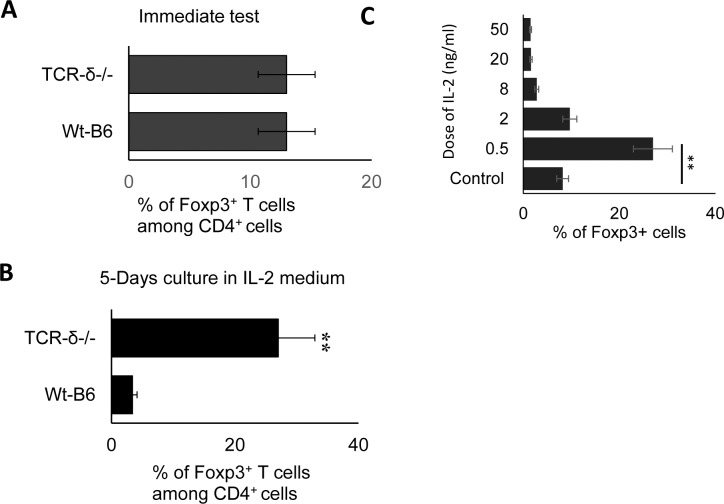
When cultured in medium containing low concentrations (1 ng/ml) of IL-2, a significantly large proportion of TCR-δ-/- T cells, as compared to wt-B6 T cells, expressed Foxp3.A&B). Groups (n = 6) of B6 and TCR-δ-/- mice were immunized with IRBP1-20/CFA. Thirteen days after immunization, CD3+ cells were separated from spleen and draining lymph nodes cells using a MACS column. They were stained with anti-mouse CD4 and anti-Foxp3 antibodies, either immediately (A) or after a 5-day culture in medium containing 1ng/ml IL-2 (B). Data are from one single experiment, which are representative of multiple (>5) independent experiments. C). Low dose of IL-2 favors Foxp3 T cell response. CD3+ cells separated from TCR-δ-/- mice were cultured in medium containing indicated amounts of IL-2. Five days later, the proportion of Foxp3+ T cells was evaluated by FACS analysis, after staining with anti-Foxp3 antibodies.